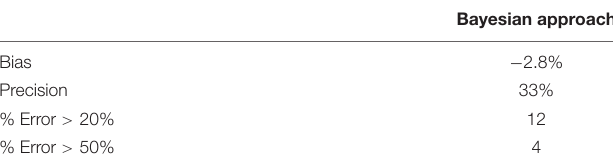
TABLE 3 | Bias and precision for AUC predictions.